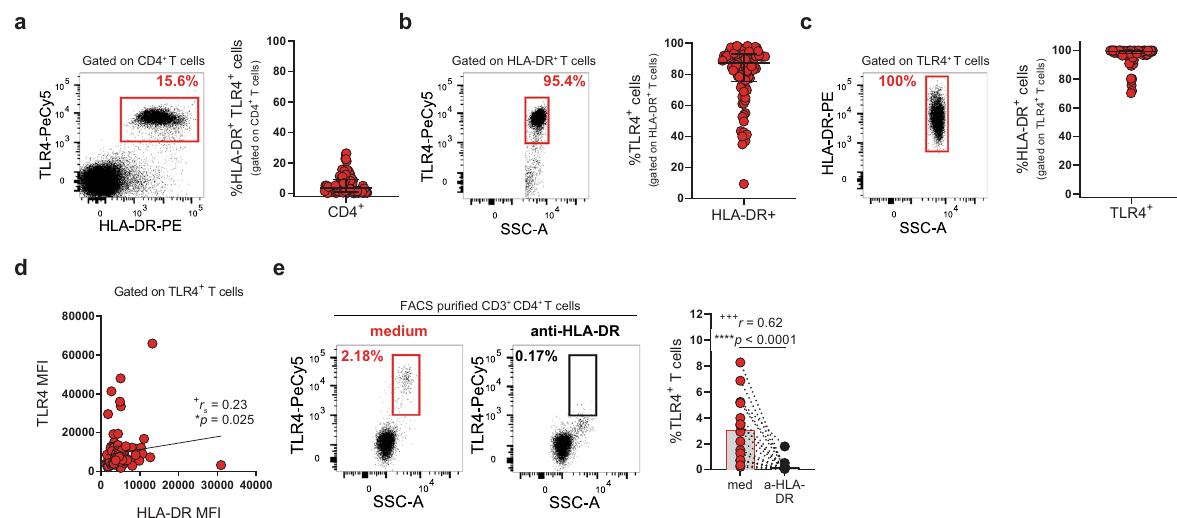
Fig. 5 Blocking HLA-DR abrogates TLR4 surface expression in T cells. a Representative plot and cumulative graph ( n = 99 RA patients) of the frequency of HLA-DR + TLR4 + T cells. b Representative plots and cumulative graph ( n = 99 RA patients) of the frequency of TLR4 expression by HLA-DR + T cells. c Representative plots and cumulative graph ( n = 99 RA patients) of the frequency of HLA-DR expression by TLR4 + T cells. d Correlation between HLA- DR and TLR4 MFIs in TLR4 + T cells ( n = 99 RA patients). e Representative plots and cumulative graph ( n = 17 RA patients) of the frequency of TLR4 + T cells after incubating FACS-puri fi ed CD4 + T cells with a blocking antibody to HLA-DR for 18 hours. Data are presented as mean ± SD, for parametric statistical tests, or median ± IQR, for non-parametric statistical tests. Sample normality distribution was tested by using D ’ Agostino & Pearson normality test. P values **** p ≤ 0.0001, *** p ≤ 0.001, ** p ≤ 0.01, * p ≤ 0.05 were determined by ( d ) Spearman correlation and ( e ) Wilcoxon matched-pairs rank